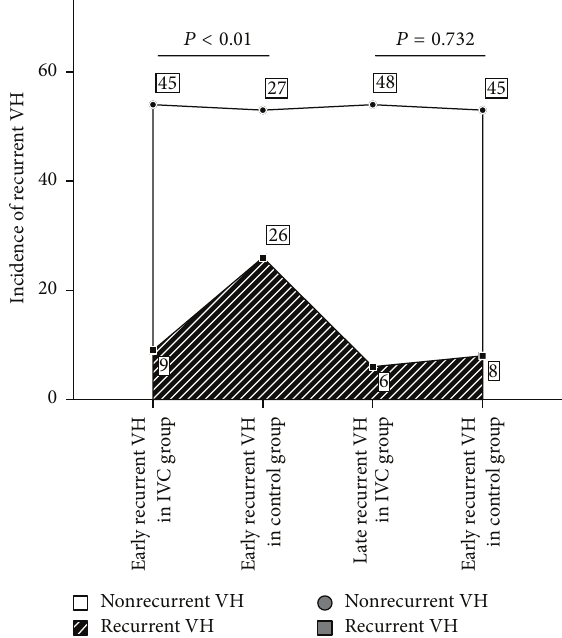
Figure 2: Bar graph showing incidence of early and late recurrent VH with or without conbercept pretreatment after surgery. Sub- grouppairwiseanalysisshowedsignificantdifferencesinearlyrecur- rent VH incidence between preoperative IVC group and control group. However, there was no statistically significant difference in late recurrent VH in both groups ( 𝑃 < 0.001 , 𝑃 = 0.732 , resp.). VH: vitreous hemorrhage; IVC: intravitreal conbercept.